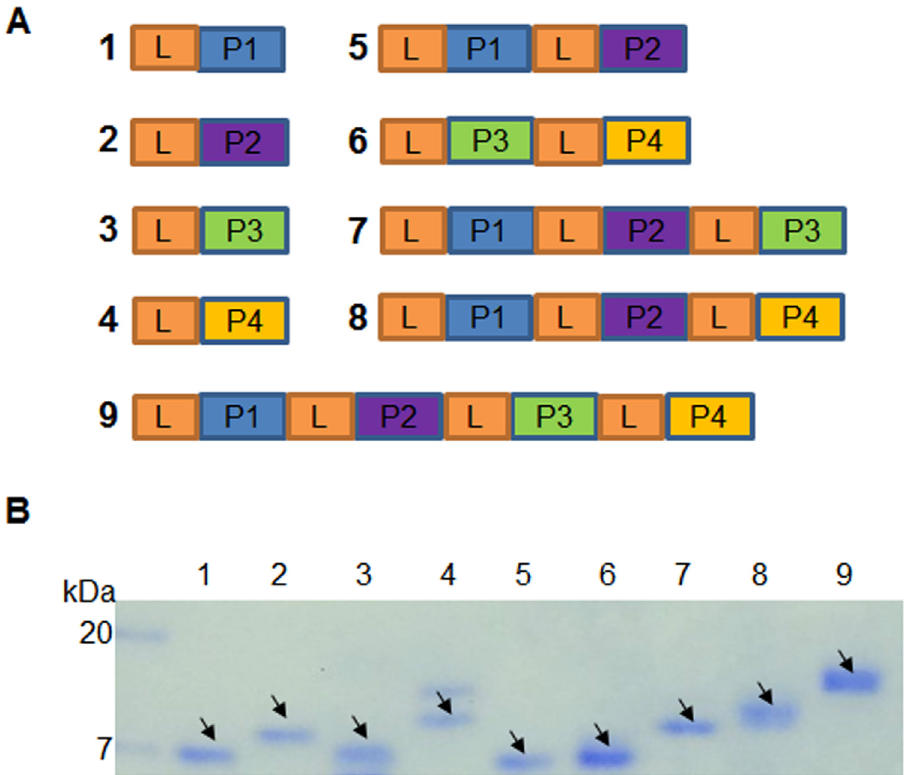
Fig 2. Expression of putative FvTox1-interacting peptides in Escherchia coli . (A), Schematic representation of nine fusion synthetic genes developed from four putative FvTox1-interacting peptide encoding genes isolated from the recombinant M13 phages (S2 Table). L represents linker. P1, P2, P3, and P4 are four peptides, PEP1, PEP2, PEP3, and PEP4, respectively, identified from four classes of phages, Classes 1, II, III and IV, respectively (Table 2). L, linker sequence GGGSGGGSGGGS. (B), Purified nine putative FvTox1-interacting proteins expressed from the nine synthetic genes (A) in E . coli (S2 Table). Arrows show the respective proteins.